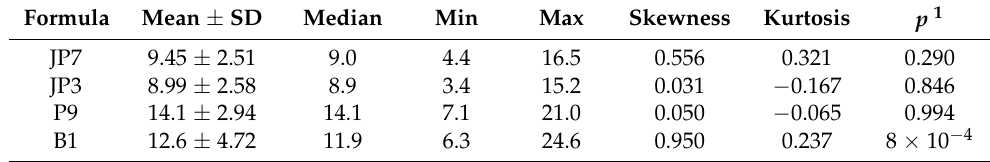
Table 3. Descriptive statistics of %BF data ( n = 54) obtained from the JP7, JP3, P9, and B1 formulas.